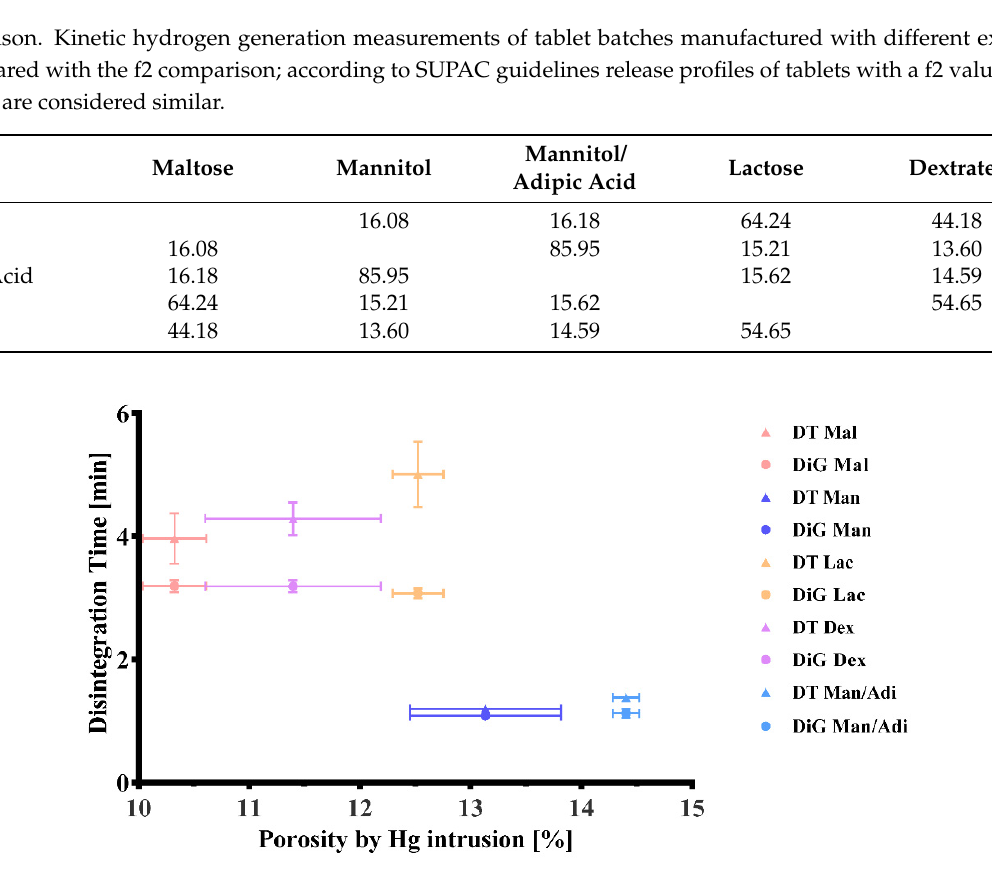
Table 1. Content, kinetic hydrogen generation, and disintegration displayed as mean and (SD)